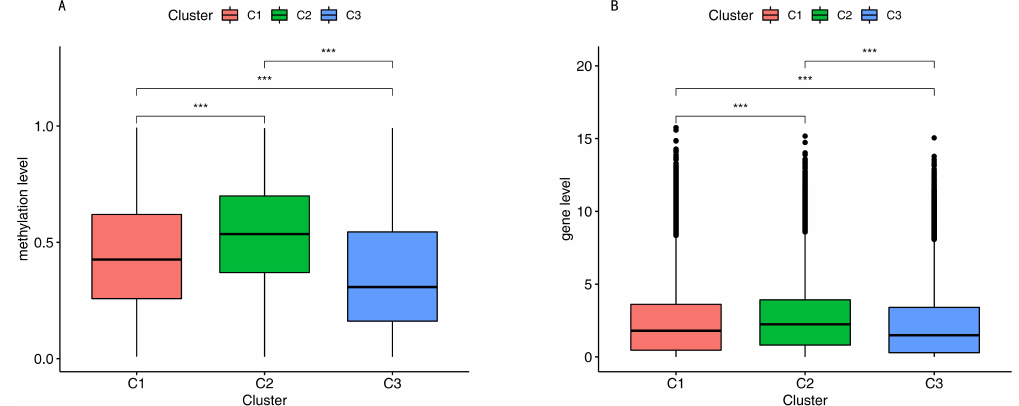
Figure 3. Methylation level and gene level. ( A ). Gene level among the three subgroups. ( B ). Methylation level among the three subgroups. Three asterisks indicate a p -value less than